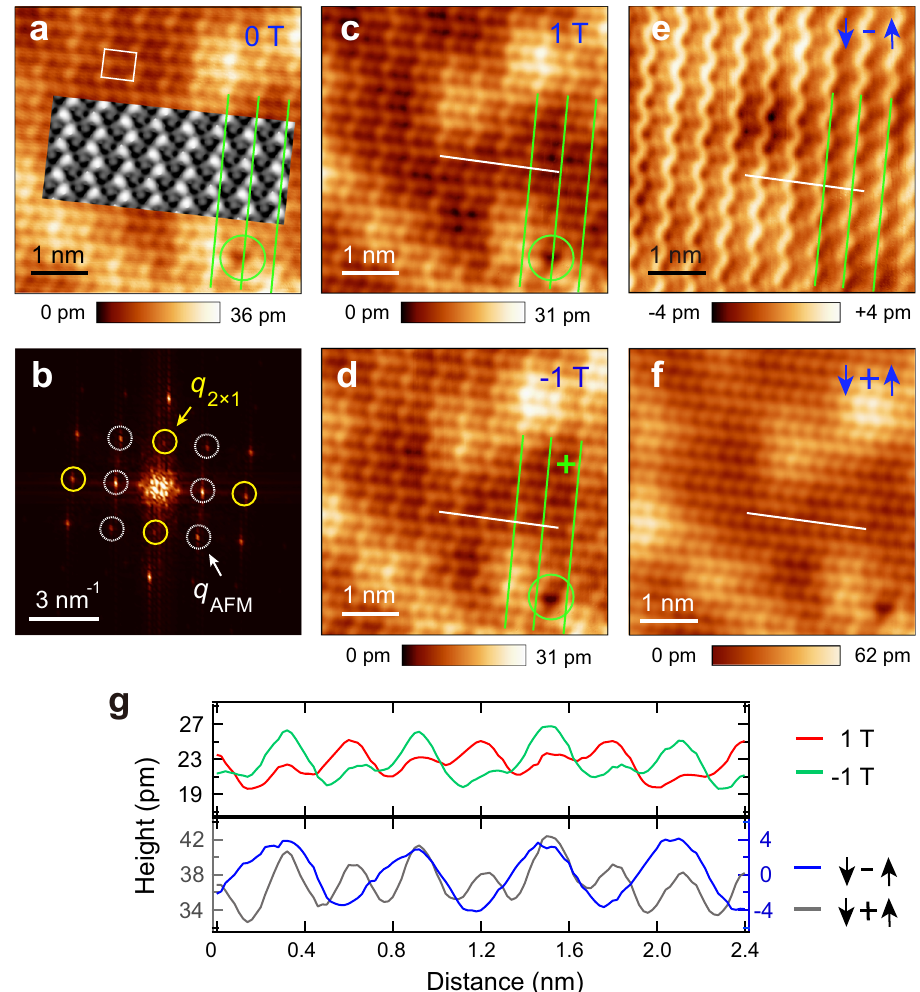
Fig. 2 Spin mapping of the zigzag AFM spin texture in 1 ML 1T-CrTe 2 . a , c , and d SPSTM images ( V b = − 0.1 V, I t = 100 pA) of 1 ML CrTe 2 taken with a Cr tip under different magnetic fi elds. Inset of ( a ) is a DFT-simulated SPSTM image of the ML CrTe 2 in the zigzag type AFM order. b FFT image of ( a ). f Sum image of ( d ) and ( c ). g Line pro fi les extracted along the white lines in ( c – f ). The green lines in ( a , c – e ) mark the direction of the zigzag spin